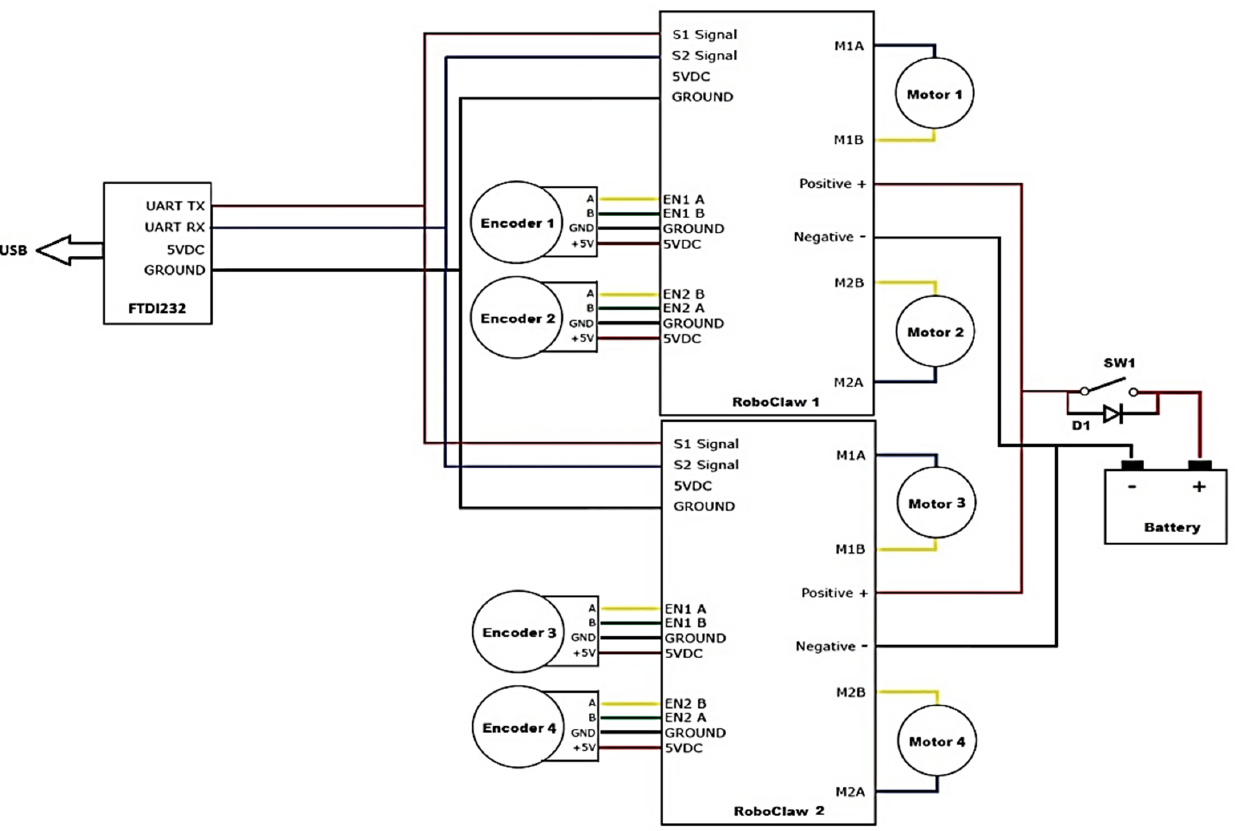
Figure 10. A scheme of the proposed control